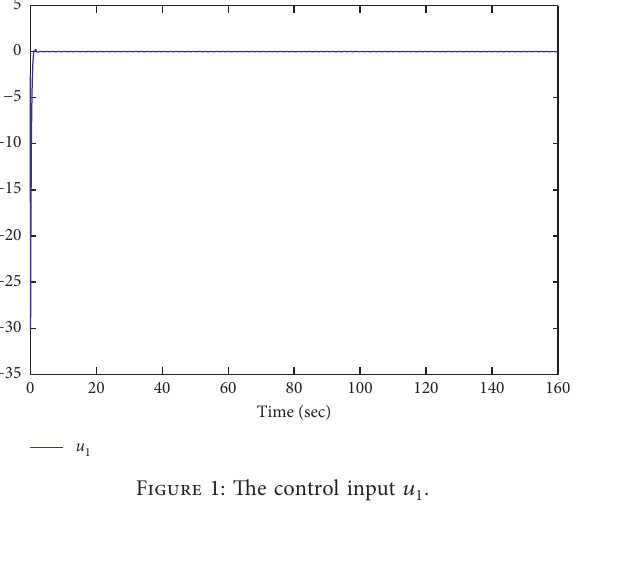
Figure 3: The state profile of x